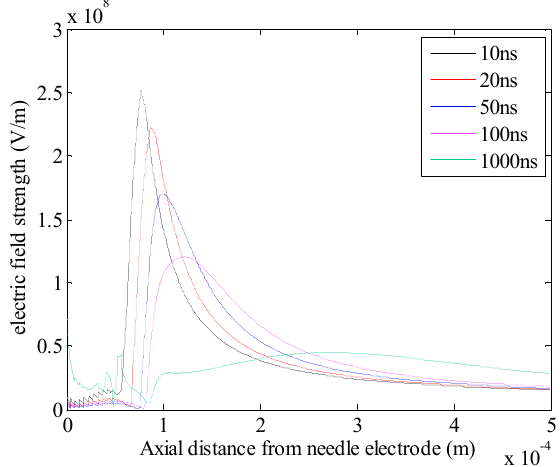
Figure 20. Electric field distribution along the needle-sphere axis as a response to 1.2 PDIV with 10 mm needle-plate electrode configuration.